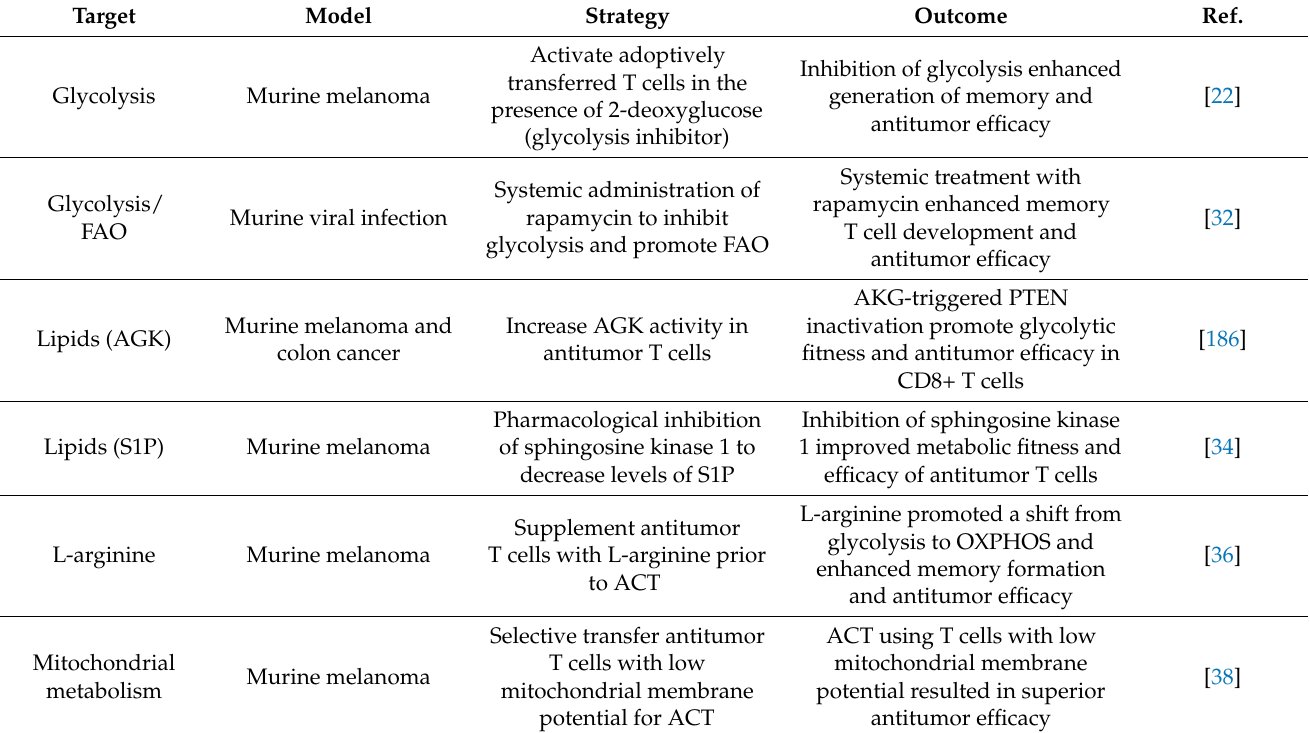
Table 2. Pre-clinical in vivo cancer models targeting metabolites and cytokines immunometabolism.